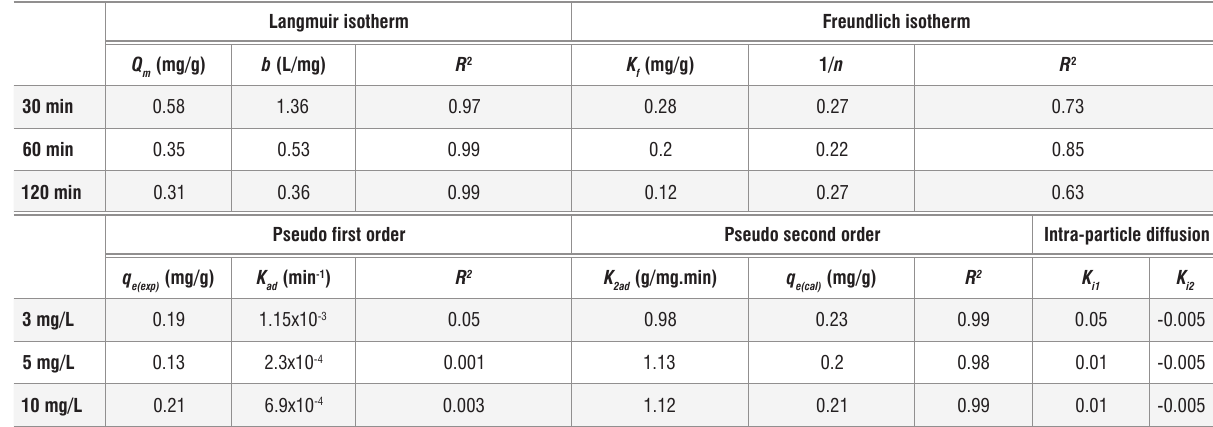
Pseudo second order Intra-particle